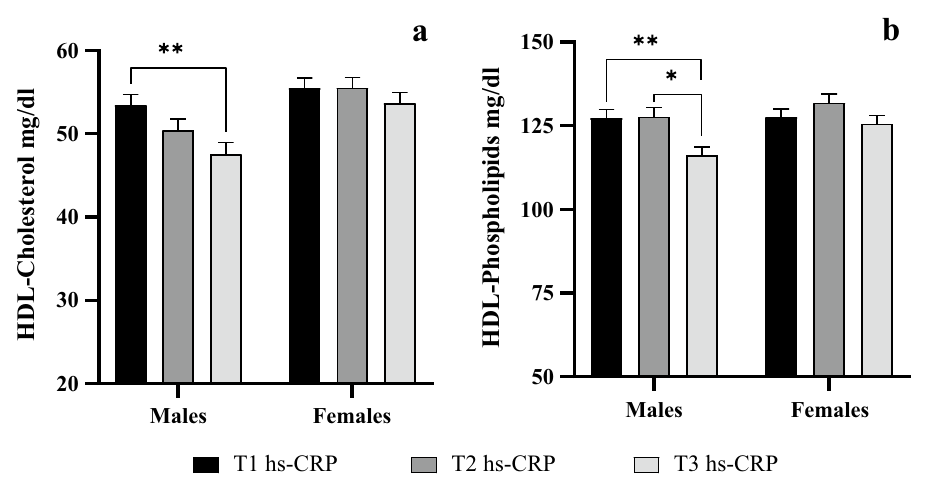
Figure 1. HDL-cholesterol ( a ) and HDL-phospholipid ( b ) levels across hs-CRP tertiles adjusting by leptin and adiponectin. The results are expressed as means and standard error. Data from ANCOVA with Bonferroni’s correction. *p < 0.05; ** p < 0.01. hs-CRP high sensitivity C-reactive